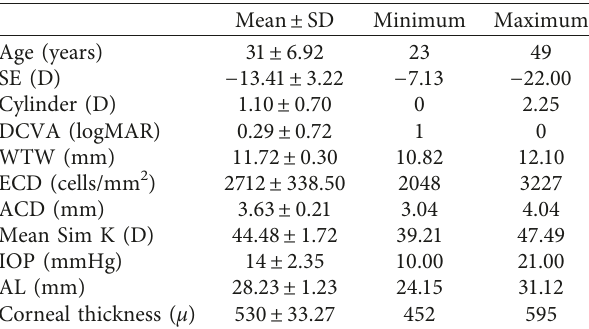
Table 1: Preoperative patient